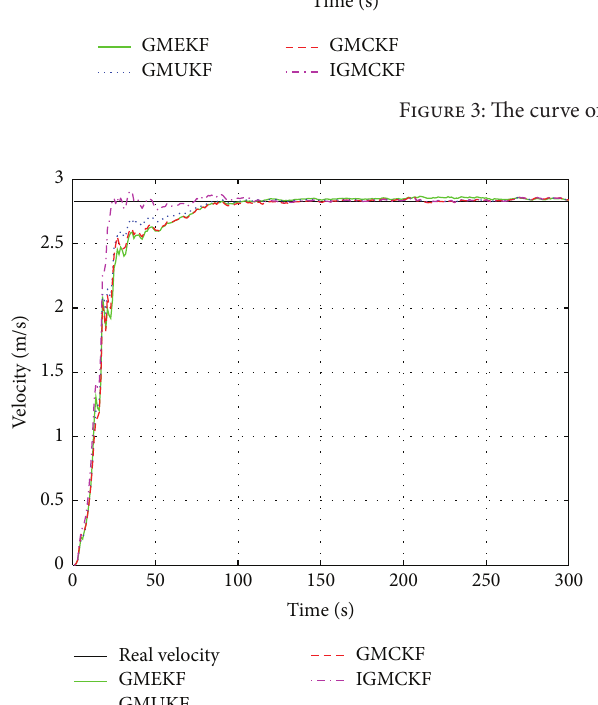
Figure 4: The tracking curve of target